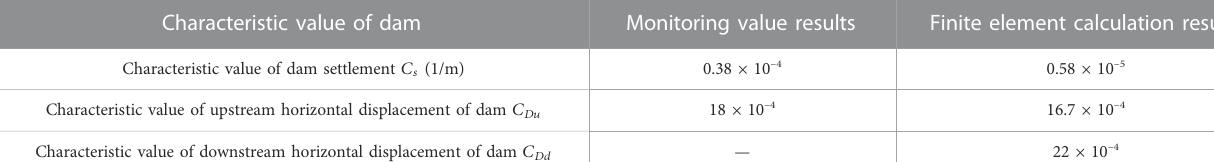
TABLE 2 Settlement and horizontal displacement ’ s characteristic value of numerical calculation and monitoring.